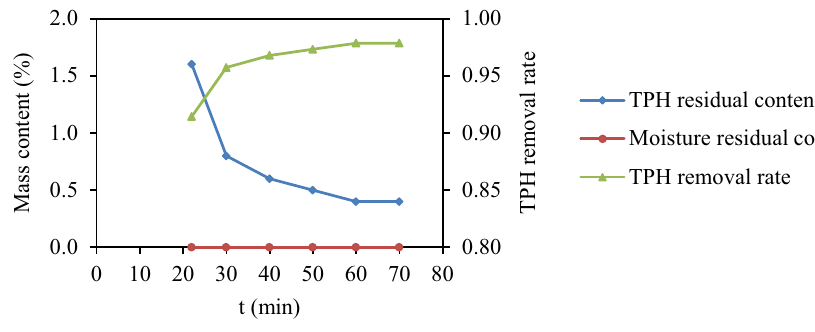
Fig. 5 Residual content of TPH and moisture in solid slag at different residence time (the terminal temperature of 350